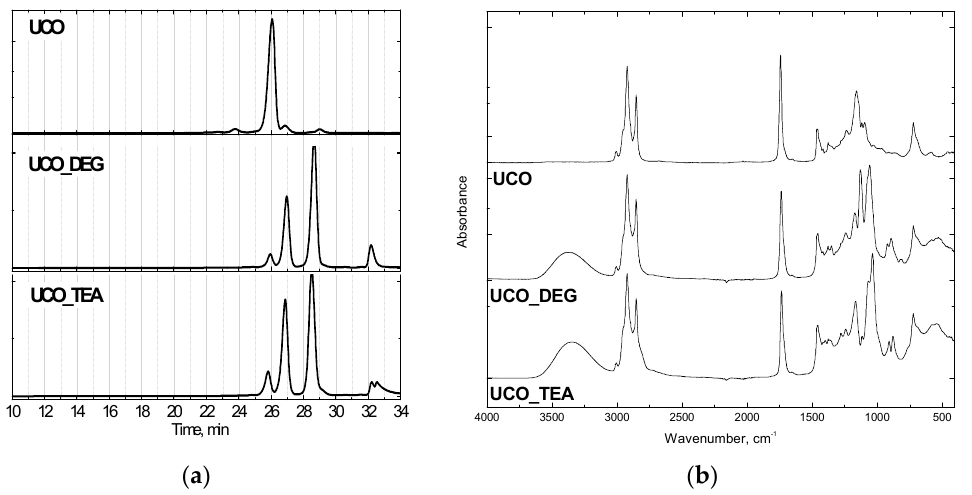
Figure 1. GPC chromatograms ( a ) and FTIR spectra ( b ) of bio-polyols.